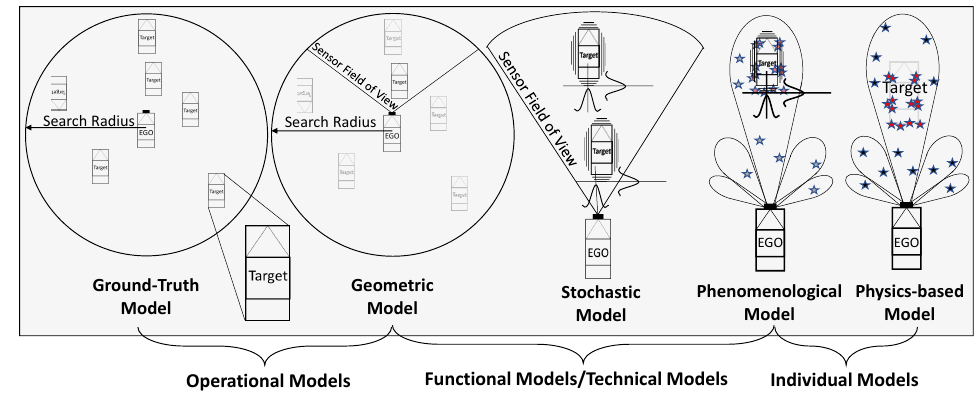
Figure 3. Sensor modelling approaches